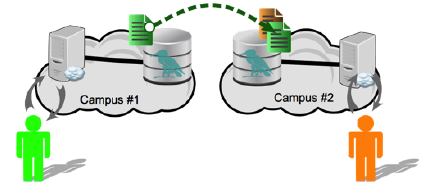
Figure 1: Illustration of data placement in dCache. Data written to a local for user storage and replicated to the remote site when accessed by a remote